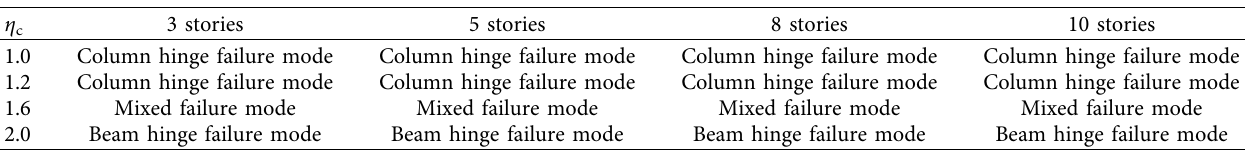
Figure 6: Capacity curves of structures with different η c. (a) 3 stories. (b) 5 stories. (c) 8 stories. (d) 10 stories. Table 3: Failure